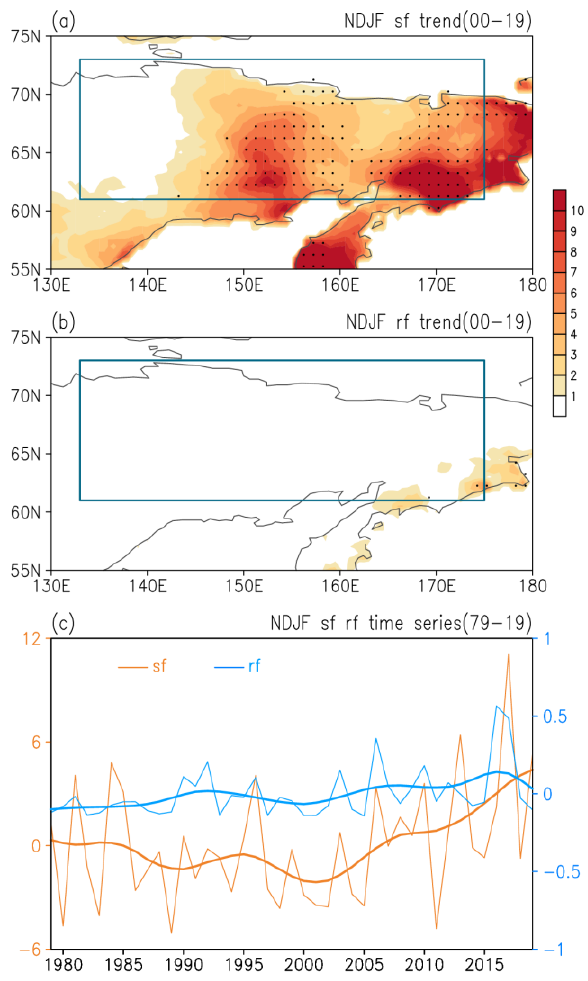
Figure 5. Linear trends of NDJF ( a ) snowfall (sf, mm month −1 10a −1 ) and ( b ) rainfall (rf, mm month −1 10a −1 ) for the period 2000 – 2019. ( c ) Time series of area-mean NDJF snowfall (orange line, mm month −1 ) and rainfall (blueline, mm month −1 ) anomalies for the period 1979 – 2019 in east Siberia (blue box covered area); thick lines are obtained by an 11-year Gaussian filter. Dotted regions in ( a , b ) denote trends significant at the 95% confidence level.